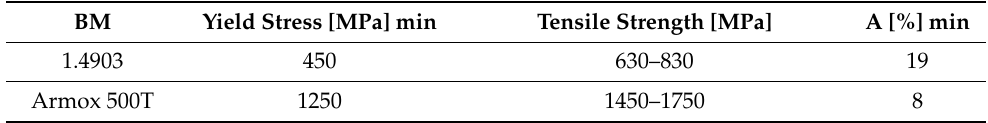
Table 3. Mechanical characteristics of the base metals